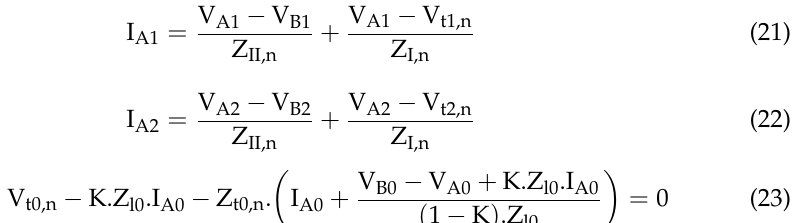
Figure 9. R f -Z II,LL curve for several fault location.